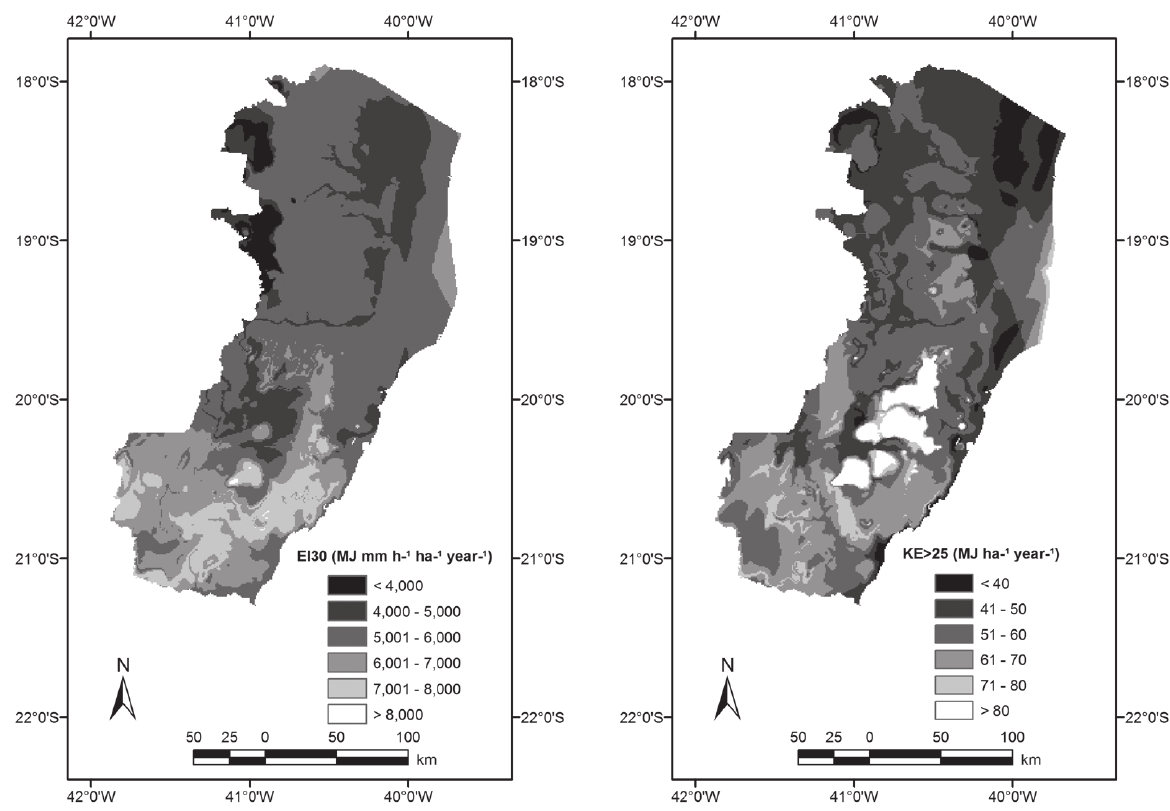
(A) and KE>25 (B) indices calculated with KE computed by the use of WM 30